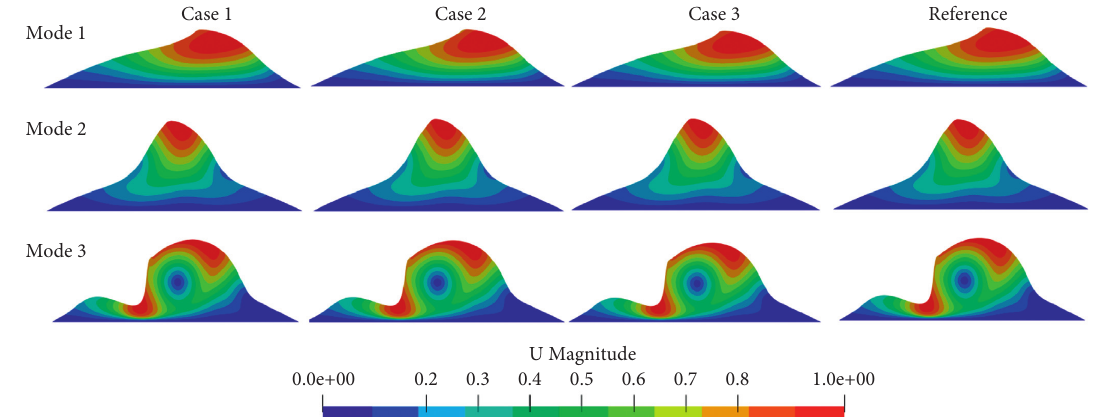
Figure 19: The first three modes of the dam in the three